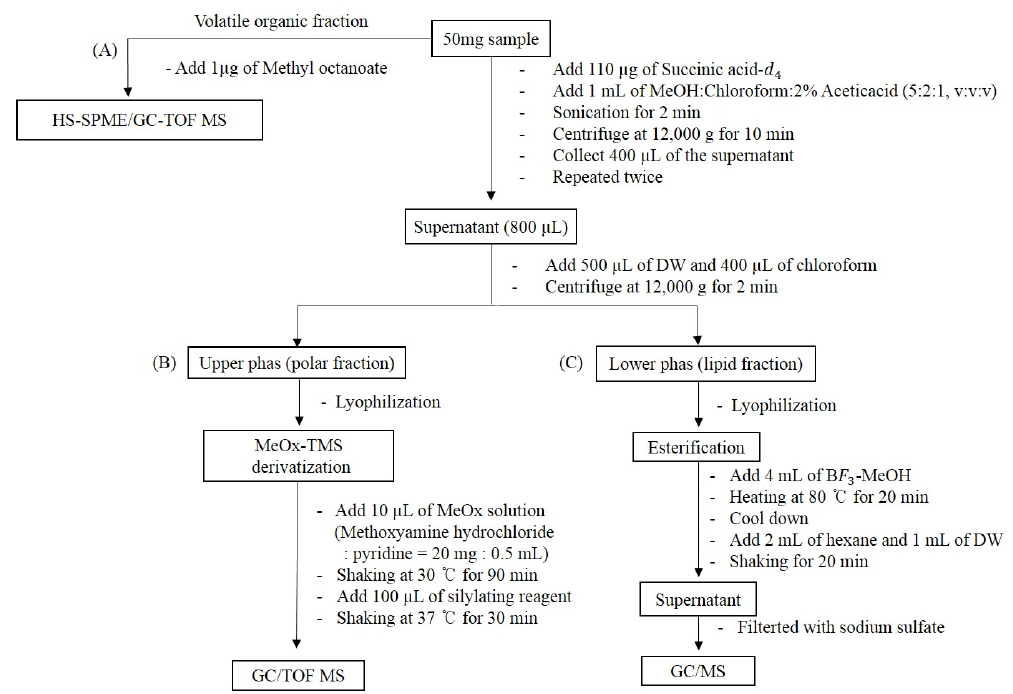
Figure 6. Integrated sample preparation for the analysis of ( A ) VOCs, ( B ) polar metabolites, and ( C ) fatty acids.